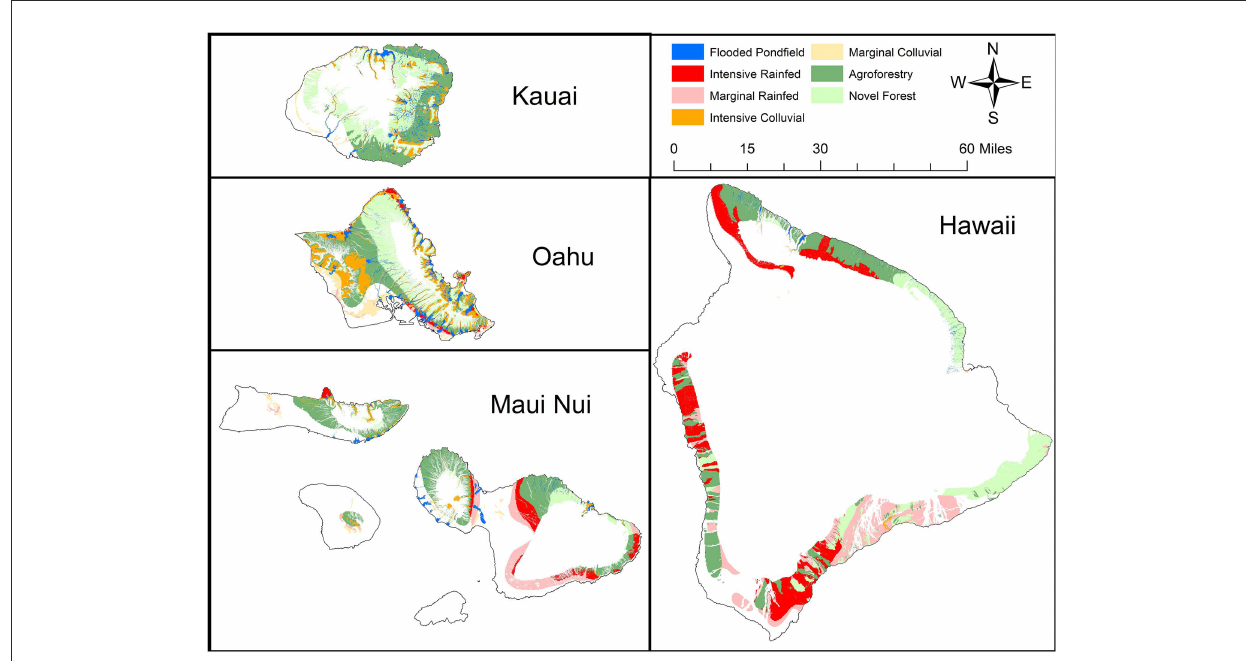
FIGURE1 The modeled spatial distribution of the seven agroecological archetypes across the Hawaiian islands.